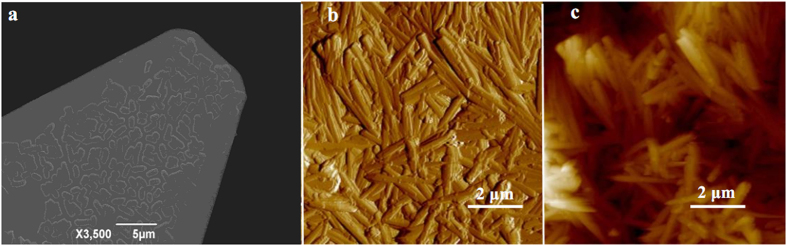
SEM image of a tipless cantilever with immobilized bacteria (a) and AFM peak force error (b) and height (c) images of goethite fixed to a Tempfix surface in deionized water.